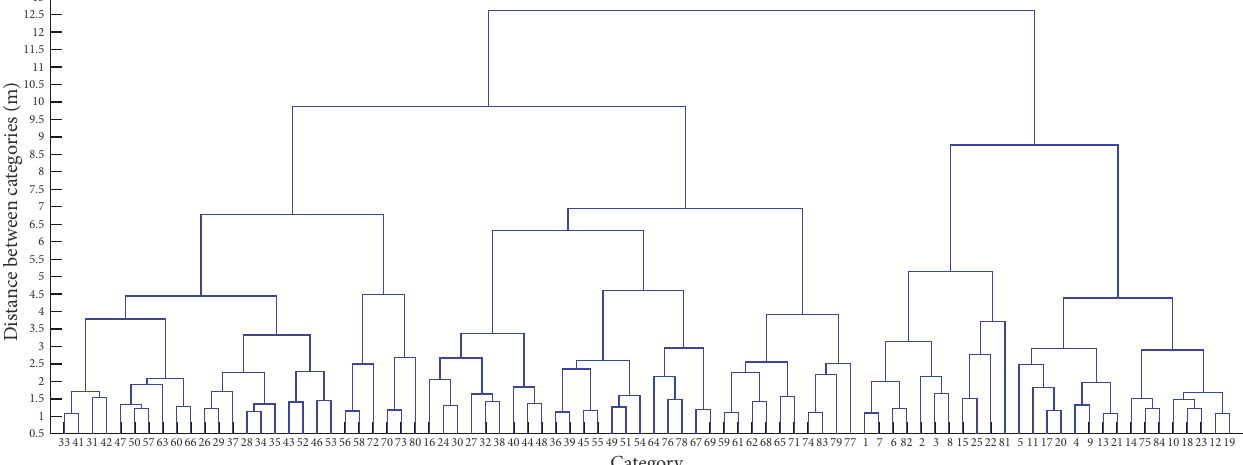
Figure 6: Origin hierarchical clustering tree.